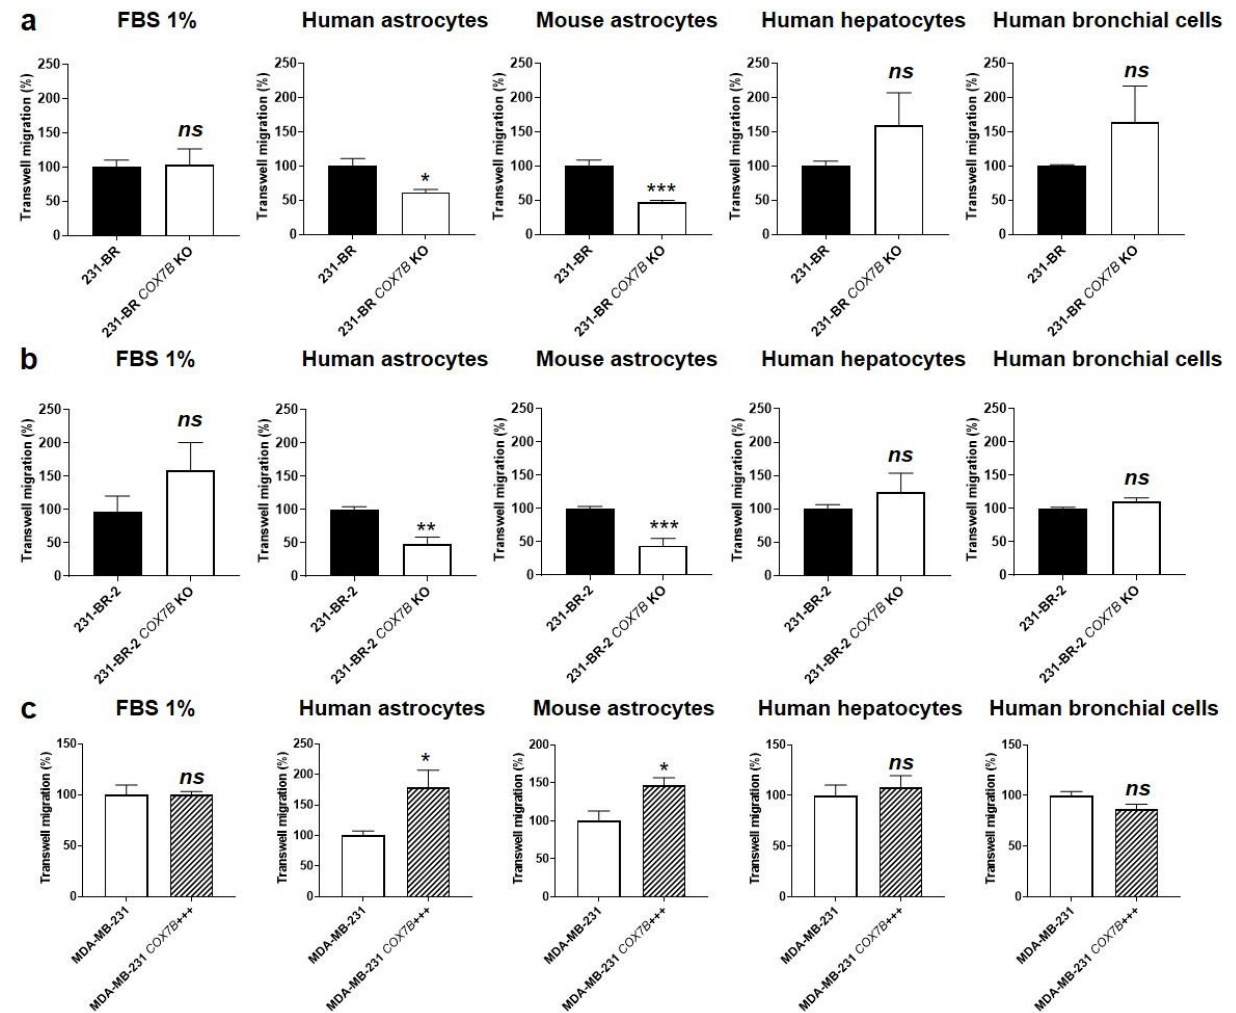
Figure 4. Cause – effect relationship between Cox7b expression and the selective migration of human breast cancer cells towards astrocytes. ( a ) Migration assayed in transwells of 231-BR brain-seeking variants, expressing or not expressing (KO using a CRISP-Cas9 strategy) Cox7b, towards 1% FBS ( n = 9), human astrocytes ( n = 3), mouse astrocytes ( n = 5), human hepatocytes ( n = 6), or human bronchial cells ( n = 6). ( b ) Migration of 231-BR-2 brain-seeking variants, expressing or not expressing Cox7b, towards 1% FBS ( n = 9), human astrocytes ( n = 5 – 6), mouse astrocytes ( n = 7), human hepatocytes ( n = 6), or human bronchial cells ( n = 6). ( c ) Migration of MDA-MB-231 parental cancer cells, overexpressing Cox7b or expressing basal levels of Cox7b, towards 1% FBS ( n = 7), human astrocytes ( n = 9), mouse astrocytes ( n = 6), human hepatocytes ( n = 6), or human bronchial cells ( n = 6). All data are normalized to control (first columns) and are shown as means ± SEM. * p < 0.05, ** p < 0.01, *** p < 0.005, ns: p > 0.05; using Student’s t-test ( a – c